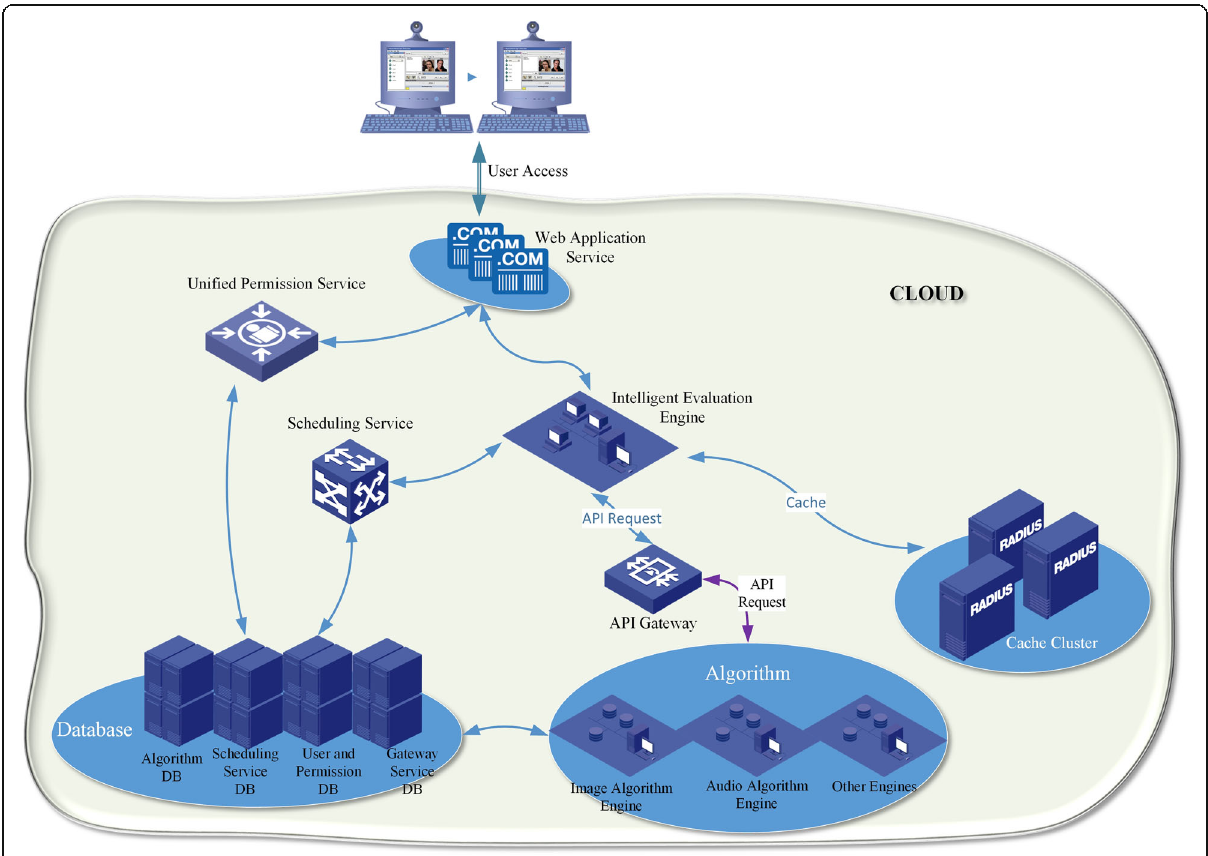
Fig. 1 Structure of CIES platform